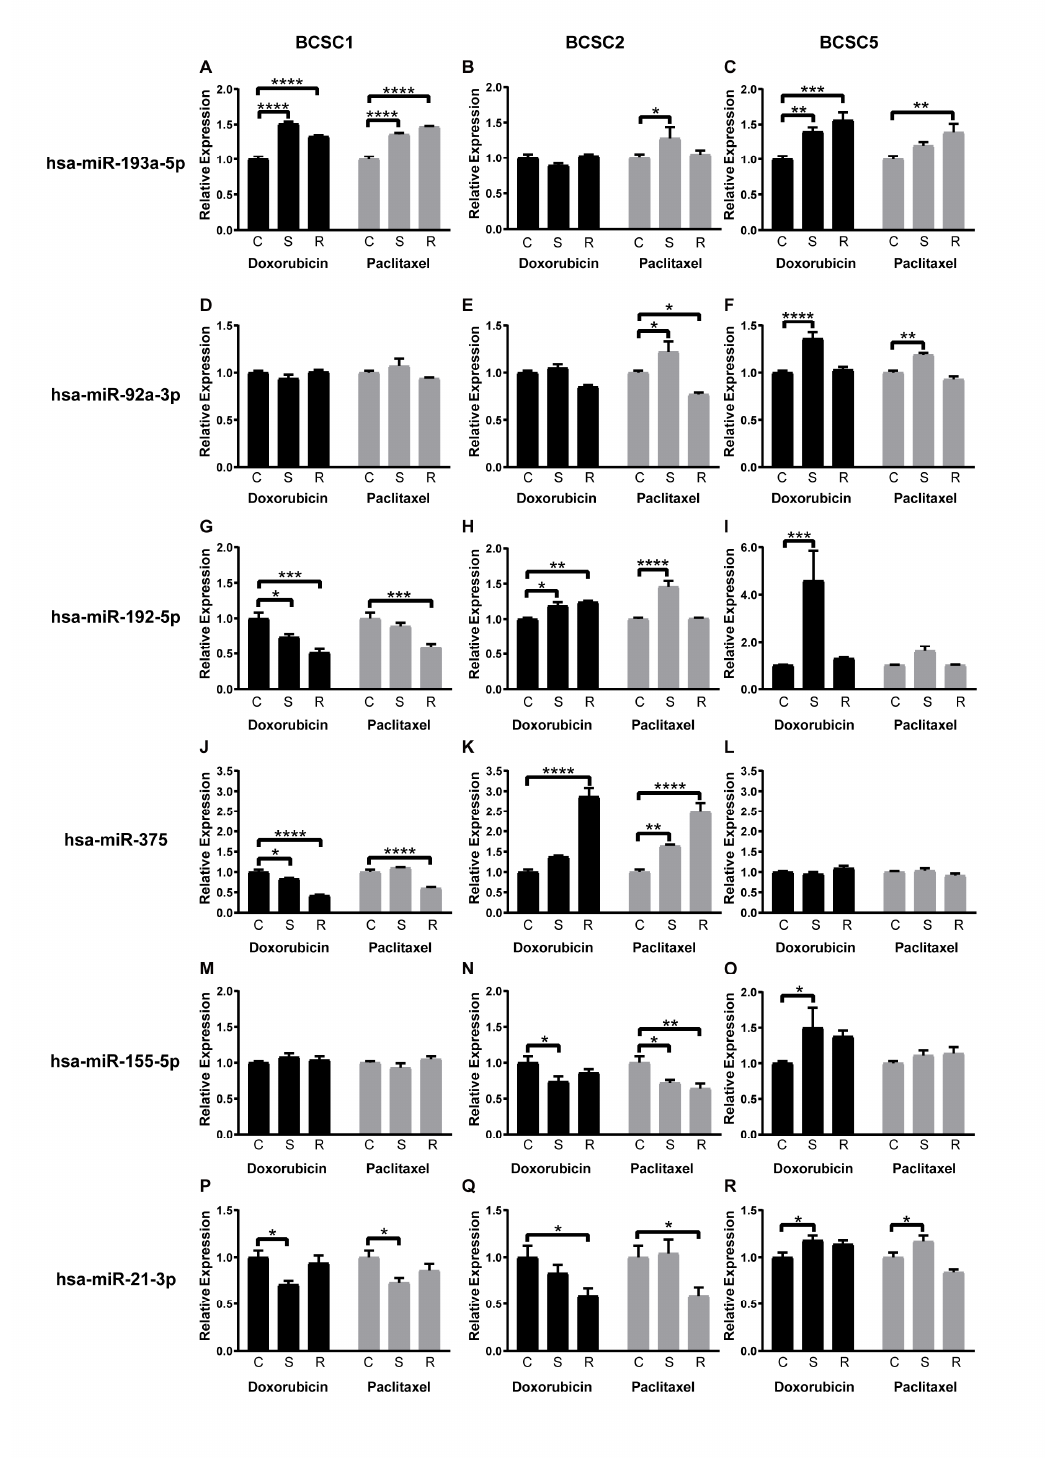
Figure 6. Chemotherapeutic stress ‐ dependent regulation of cancer ‐ related miRNA expression pattern. ( A – C ) MiR ‐ 193a ‐ 5p expression fold change for surviving (S) and recovered (R) BCSCs from doxorubicin or paclitaxel treatments, compared with untreated control cells (C), ( D – F ) MiR ‐ 92a ‐ 3p, ( G – I ) MiR ‐ 192 ‐ 5p, ( J – L ), MiR ‐ 375, ( M – O ) MiR ‐ 155 ‐ 5p, ( P – R ) MiR ‐ 21 ‐ 3p, n = 3, data represent means +SEM. * = p < 0.05; ** = p < 0.01; *** = p < 0.001; **** = p < 0.0001 by two ‐ way